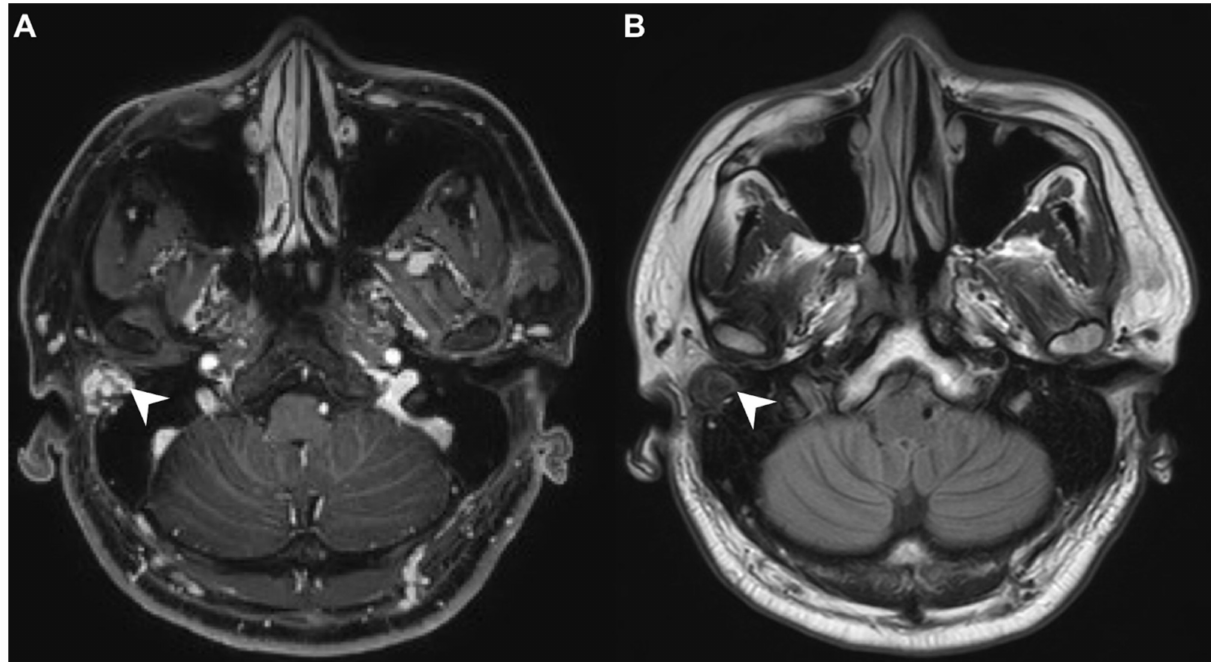
Figure 3. ( A ) On magnetic resonance imaging (MRI), the T1-contrast sequence revealed a heterogeneous hyperintense mass in the right EAC (arrow). ( B ) On MRI, the T2-sequence yielded a well-circumscribed isointense signal from the mass (arrow).